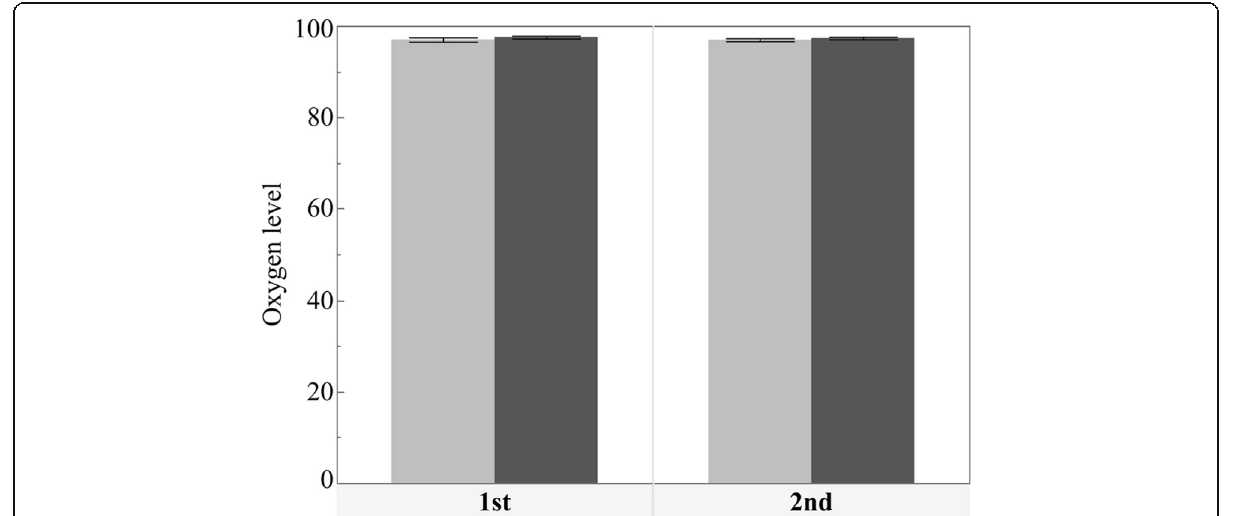
Fig. 3 Bar chart showing the mean SpO 2 scores before and after operation